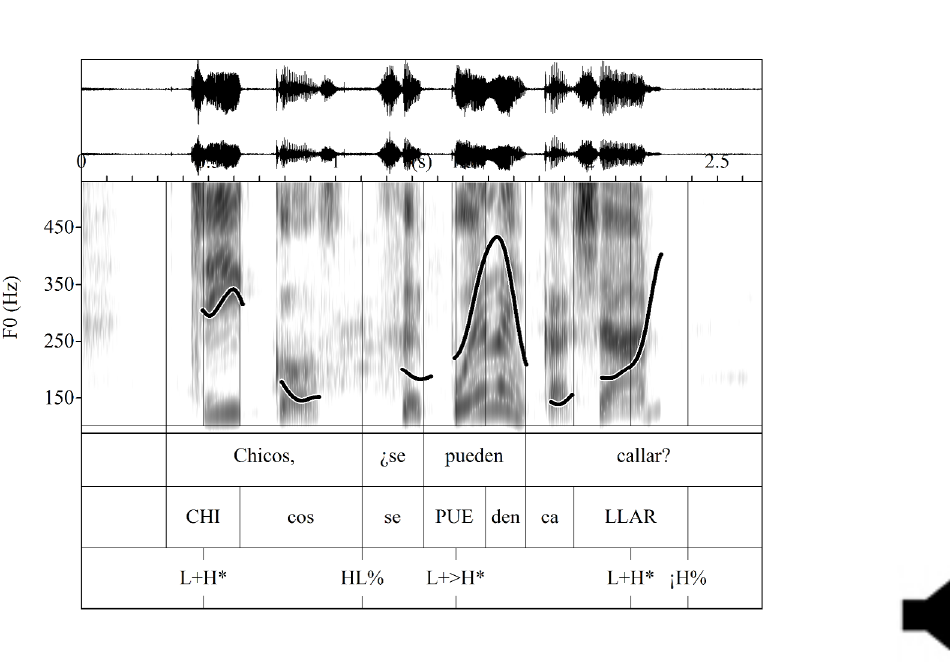
Figure 27 (Participant 4) : Waveform and F0 trace for the vocative within the imperative yes-no question ¿ Chicos, se pueden callar? ‘Kids, can you please be quiet?’ produced as one IP: L+H* (nuclear position) and HL% (boundary tone).